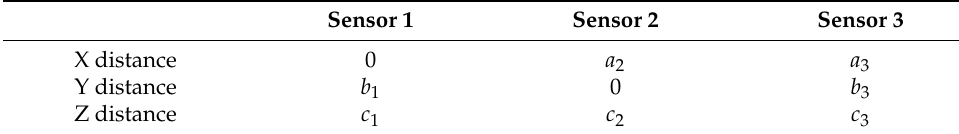
Table 1. Spatial location parameters of three different sensors.